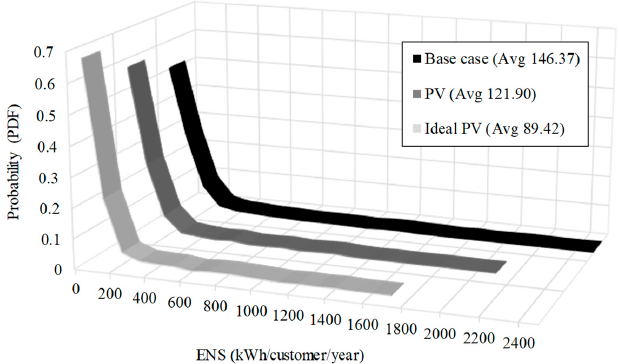
Figure 7. Impact of PV integration on network ENS to customers.